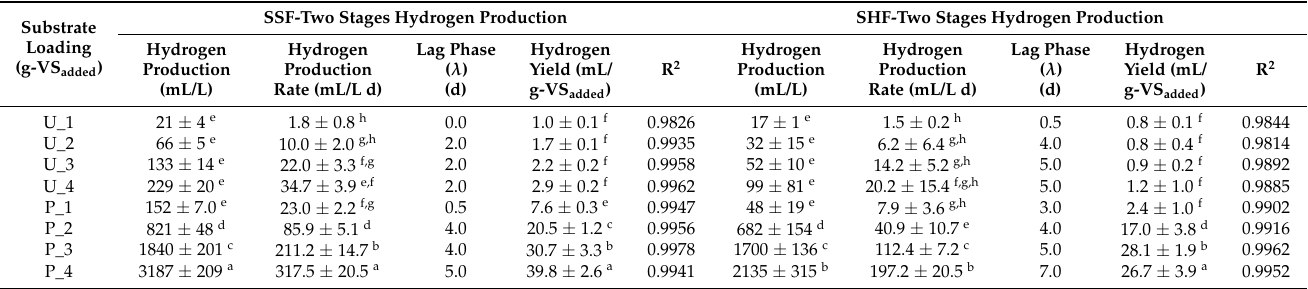
Table 5. Comparison of hydrogen production by SSF and SHF of the two-stage hydrogen production